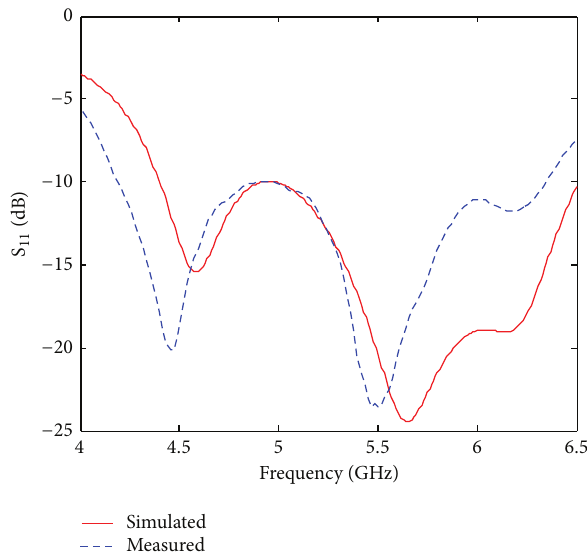
Figure 11: Measured and simulated frequency behavior of the magnitude of the reflection coefficient.